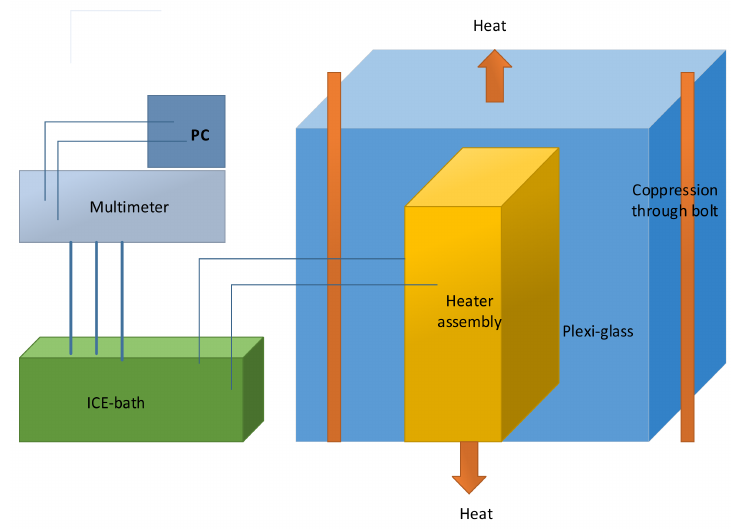
Figure 10. Thermal conductivity measurement setup (method one-direct steady state measurement) [36].